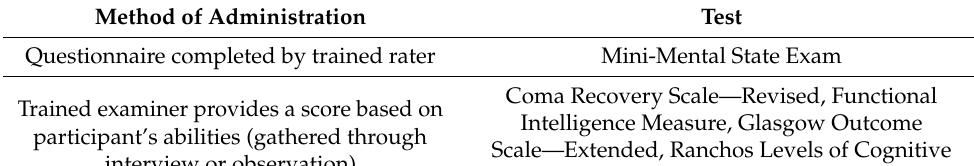
Table 4. Methods of administering and scoring assessments of cognition in coma